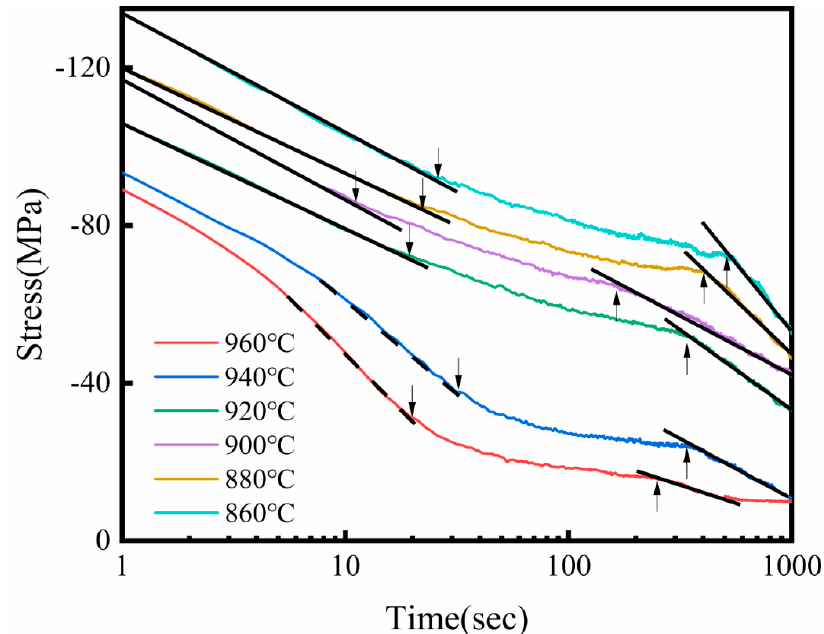
Figure 2. Stress relaxation curves for Ti microalloyed steel in a two-stage controlled compression process at different isothermal temperatures . The two arrows in each curve indicated the P s and P f points.